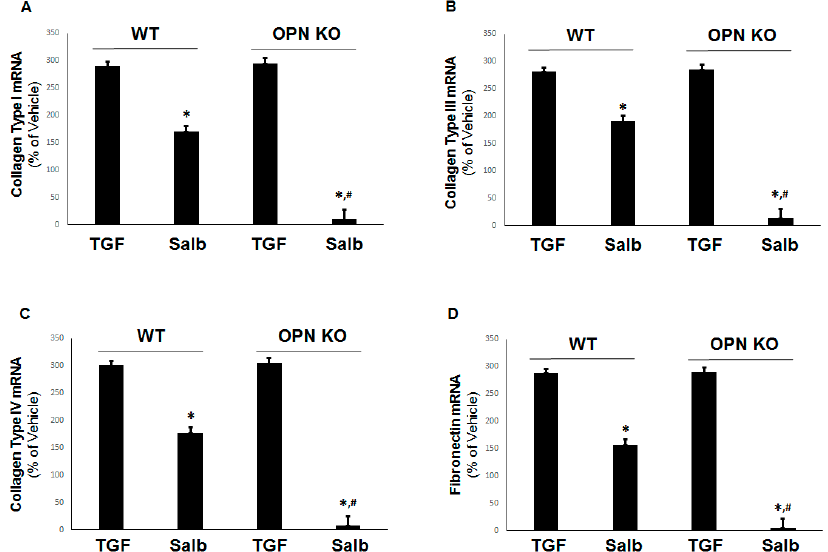
Figure 4. Absence of OPN potentiates the β 2 AR-mediated inhibition of TGF β -dependent profibrotic factor mRNA induction in H9c2 cells. mRNA levels of ( A ) type I collagen, ( B ) type III collagen, ( C ) type IV collagen, and ( D ) fibronectin, in WT or OPN-depleted (OPN KO) H9c2 cells treated with 10 ng/mL TGF- β 1 (TGF) with or without 10 µ M salbutamol (Salb). *, p < 0.05, vs. TGF; # , p < 0.05, vs. WT-Salb; n = 3 independent experiments per condition (two-way ANOVA with Bonferroni